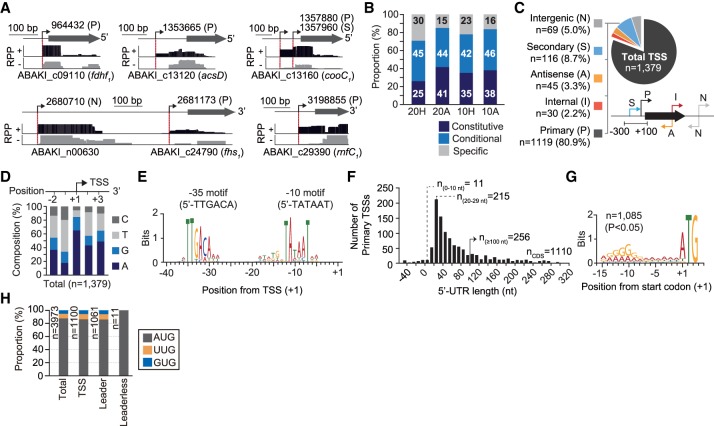
The transcription architecture of the A. bakii DSM 8239 genome. (A) Examples of dRNA-seq profiles mapped onto the A. bakii genome. Complementary DNA (cDNA) reads mapped to genome from RNA 5′-pyrophosphatase-treated (RPP+) and -untreated (RPP−) libraries are shown to represent the genomic regions. A red bar indicates the position of transcription initiation, which is identified by enriched 5′-ends of aligned dRNA-seq reads in RPP+ libraries (two biological duplicates) and nonenriched 5′-end reads of aligned dRNA-seq reads in RPP− libraries. See also Supplemental Figure S4A. (B) The proportion of constitutive (shared by all conditions), conditional (existing in two or more conditions), and specific (unique to a single condition) TSSs across the four conditions. (C) Categorization of 1379 TSSs identified in all samples. Primary TSSs (P) have a maximum peak density within a distance <300 bp upstream and 100 bp downstream from annotated genes; secondary TSSs (S) are associated with the same ORF as a nearby primary TSS but have lower peak density; internal TSSs (I) are located on the same strand as an annotation; antisense TSSs (A) are located on the opposite strand as an annotation; and intergenic TSSs (N) are those not falling into any of the above-mentioned categories. See Supplemental Table S6 for all TSS information and noncoding RNA lists, respectively. (D) Distribution of each nucleotide around the TSS (+1). (E) Motif searches upstream of A. bakii TSSs for all TSSs. See also Supplemental Figure S5. (F) Distribution of the 5′-UTR lengths of primary TSSs. (G) Conserved AG-rich Shine-Dalgarno (SD) sequences for 1085 protein-coding transcripts. (H) The frequency of start codons of all 3973 ORFs, 1100 TSS-assigned ORFs, 1061 ORFs containing 5′-UTRs (leader sequence), and 11 leaderless ORFs.